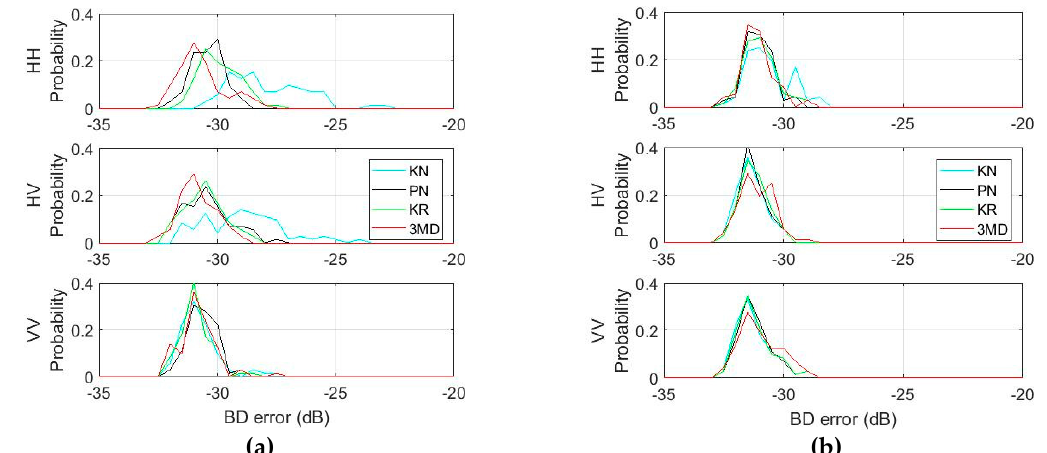
Figure 20. BD histogram for SETHI, Run 8. ( a ) X-band, ( b ) L-band.